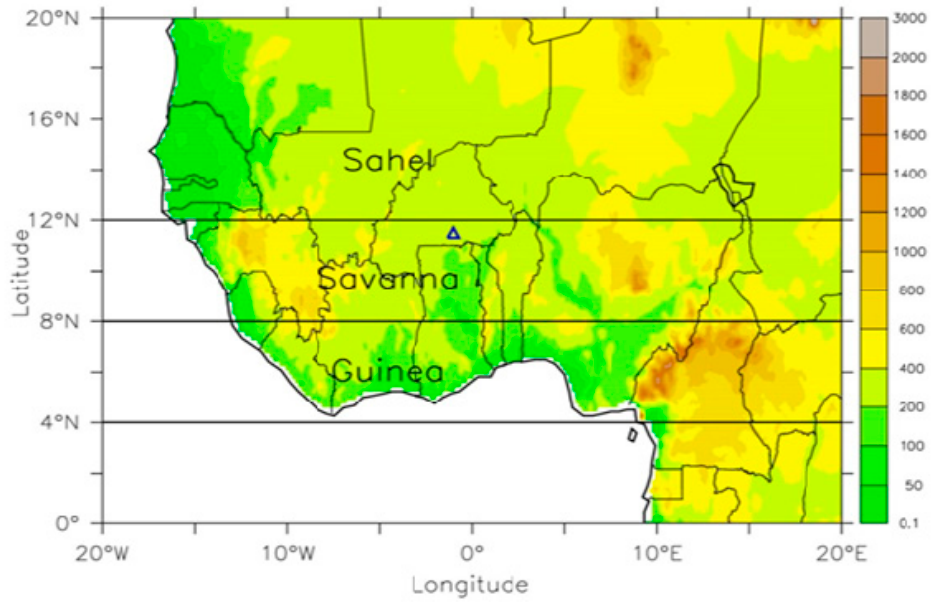
Figure 1. West African topography and the three Food and Agriculture Organizations (FAO)- Agro-ecological zones (AEZs): the Guinea, Savanna, and Sahel zones [25,34]. Different crops are grown in various parts of West Africa. Some of the major crops grown in the